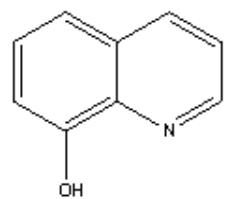
Figure10. Structure of 8-hydroxyquinoline isolated from C. diffusa root